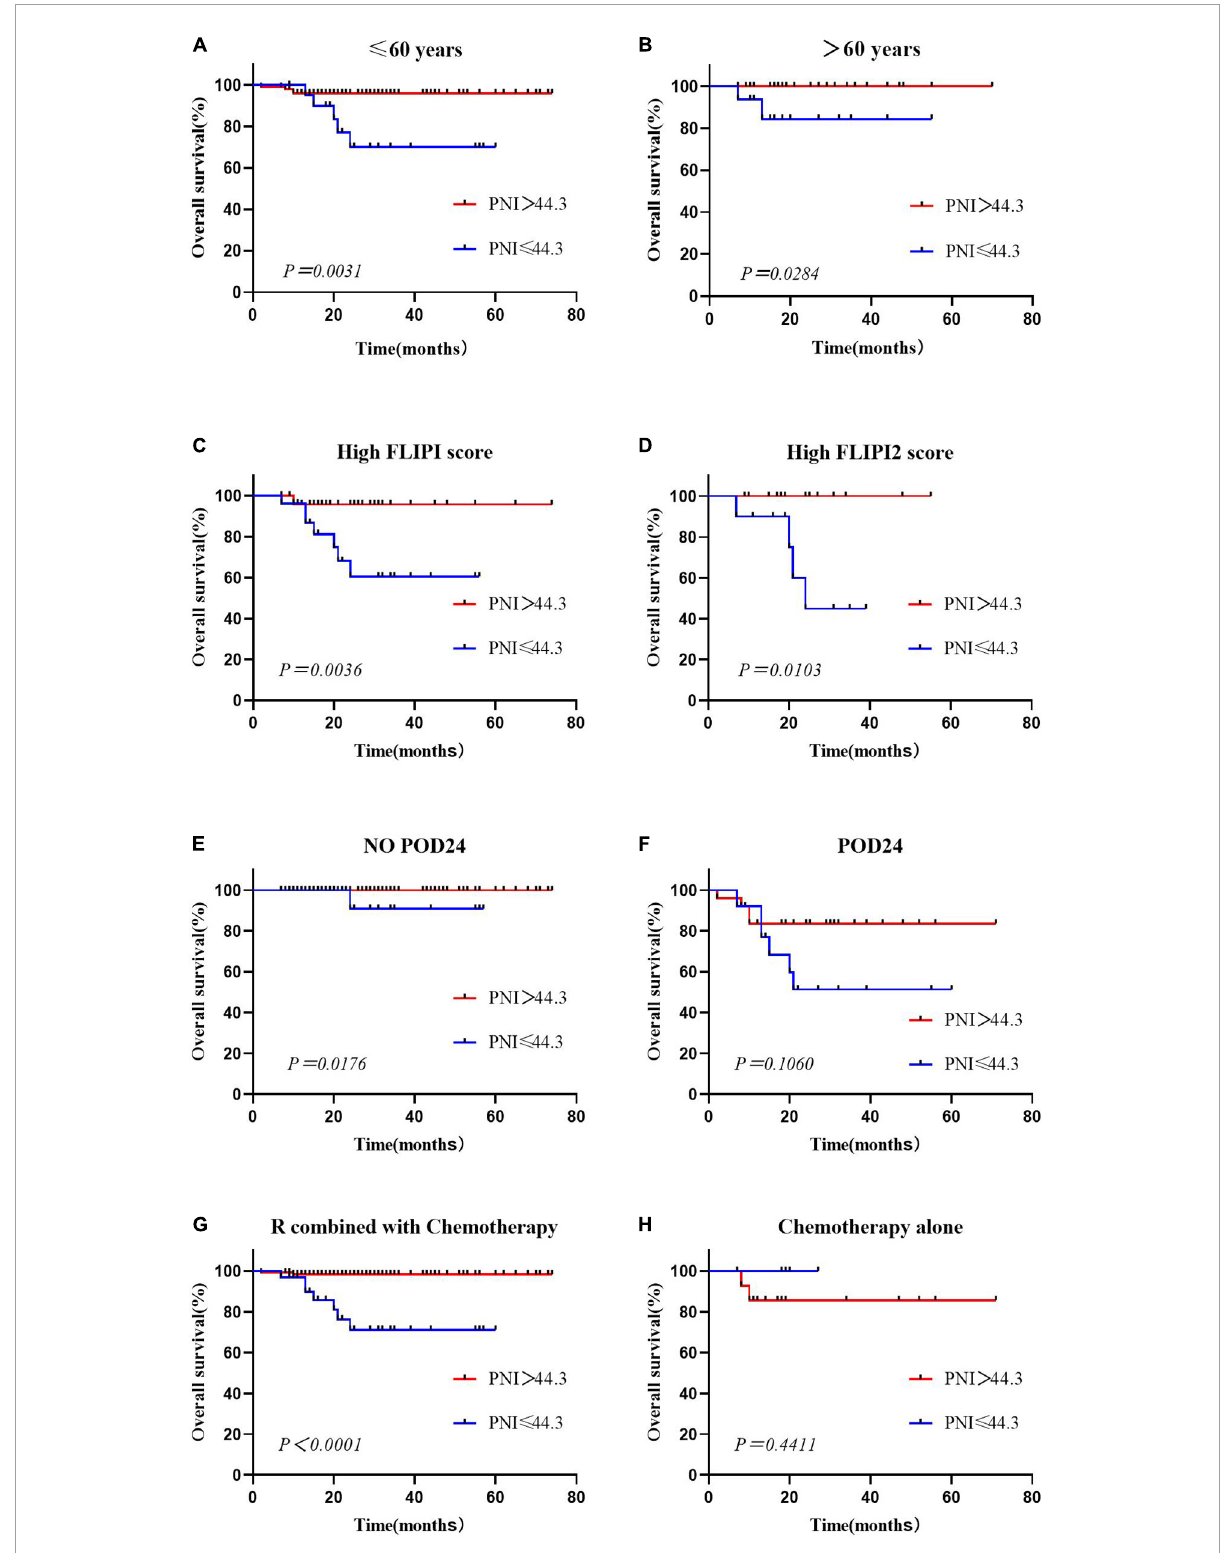
FIGURE3 Overall survival according to the prognostic nutritional index and age (A,B) , High FLIPI score (C,D) , presence or absence of POD24 (E,F) and treatment regimen (G,H)